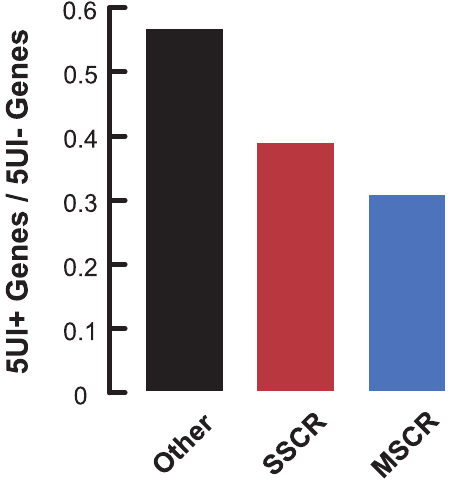
Figure 1. 5 9 UTR introns (5UIs) are depleted in genes that contain SSCRs and MSCRs. Fraction of genes with 5UIs was plotted for SSCR, MSCR or other human protein coding genes.